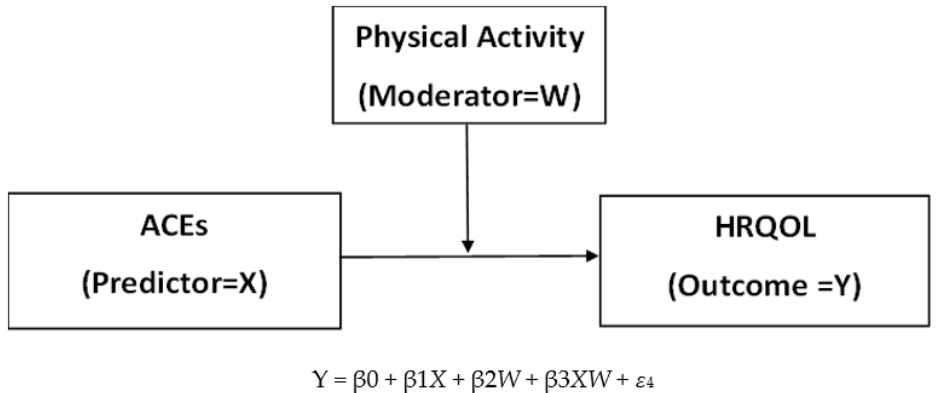
Figure 2. Framework of the moderation model—the role of PA in the relationship between ACE and HRQOL. Note: This is a basic model. Models with sub-domains of ACEs and HRQOL are omitted.